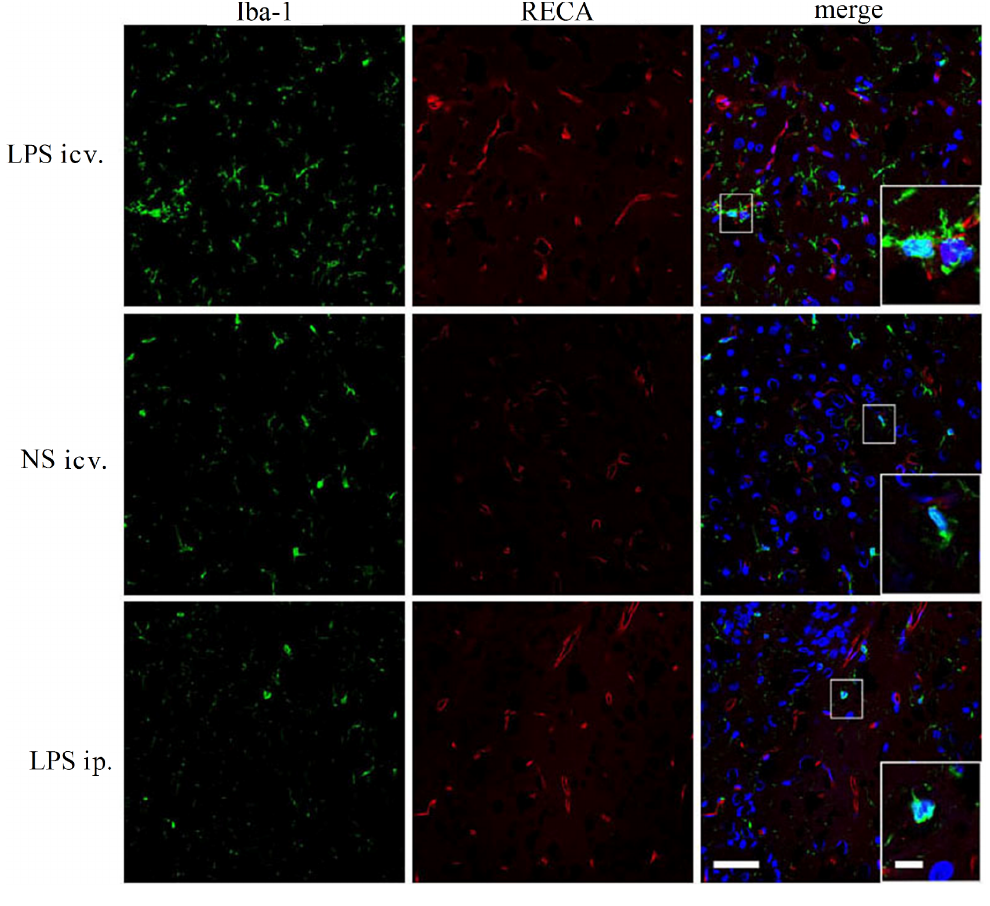
Figure 7. Representative micrographs of immunofluorescent labeling for Iba-1 (green) and RECA (red) in the brains of the rat at P1. In the central LPS injection group, Iba-1 positively labeled microglial cells distributed more widely than that in the brain (frontal cortex in this figure) treated with ip. injection of LPS or NS. Microglial cells were activated (indicated by large cell bodies and thick processes) while in the brains of rats treated with ip. injections of LPS, there were fewer Iba-1 positively labeled cells and these cells remained in the resting state (indicated by their cell bodies and processes), similar to those in the NS-treated brain. RECA immunolabeling revealed no significant difference in the morphology and distribution of the capillaries among these three groups. Amplified boxes were inserted in the merged pictures. Bar outside the box for all the images, 50 µm; Bar inside the box for all the insertions, 10